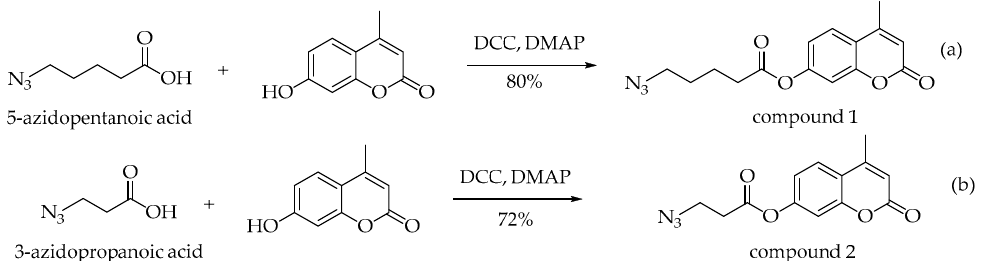
Figure 6. The synthesis of compounds 1 ( a ) and 2 ( b ).